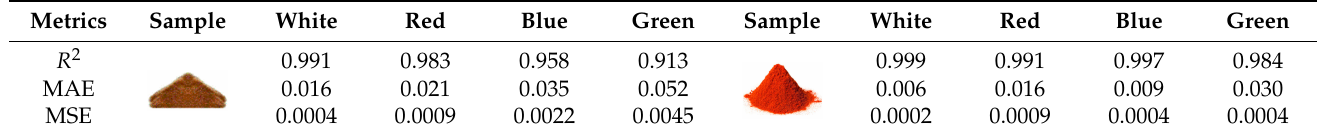
Table 4. MLR performance metrics for each color dataset for the fish feed and paprika samples.